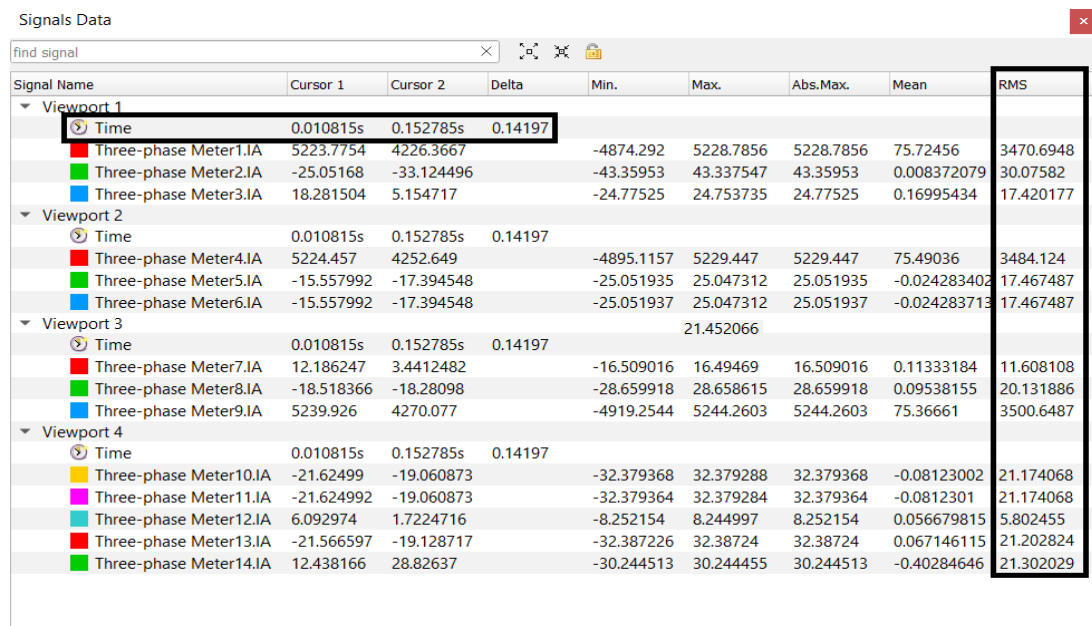
401 Figure 10. A 3LG fault at bus 9 in islanded mode.